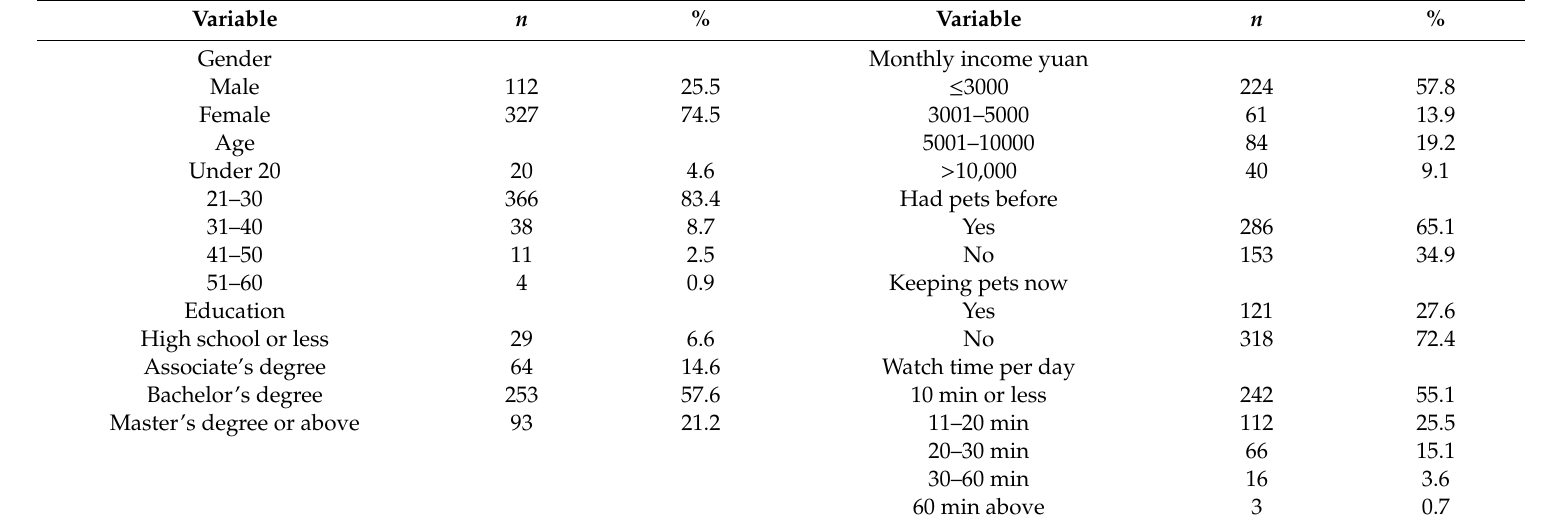
Table 2. Sample profile ( N =